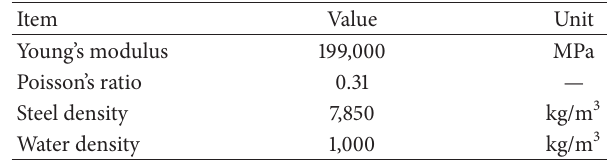
Table 1: Material properties.